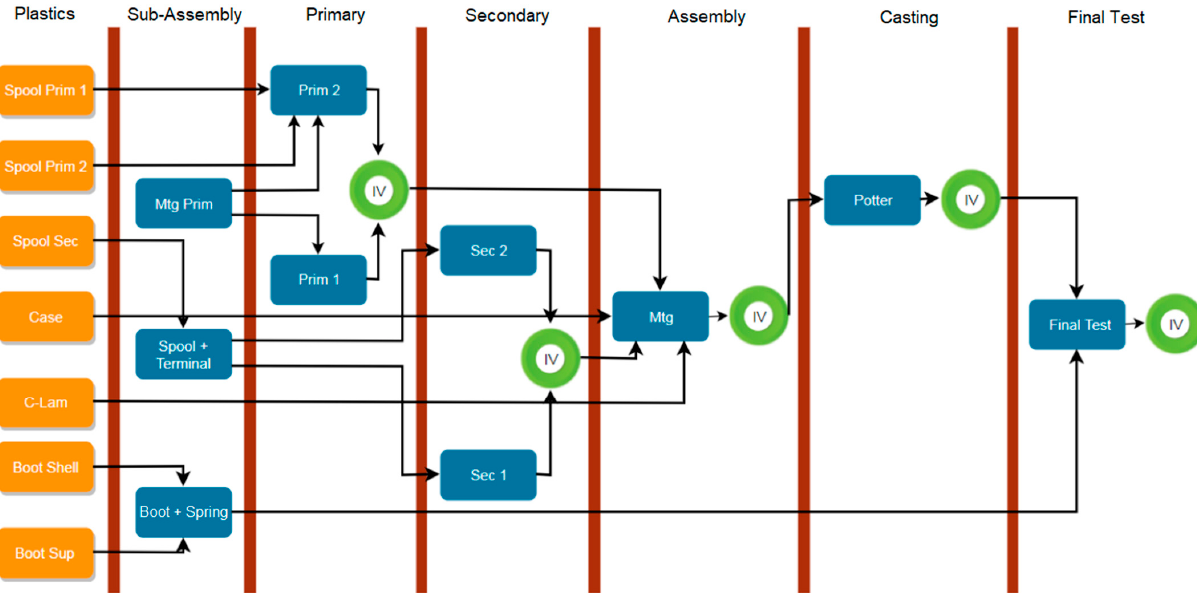
Figure 5. Process schematic of injection coil 1 production line. The representation by colors are as follows: all the machines on the production line, the plastic injection machines, where the plastic components that make up the part (orange), the assembly stations (Mtg), winding, casting, and final testing are molded (blue) and the visual inspection stations, where the operator inspects the parts or lots at the exit of the critical machines (green).